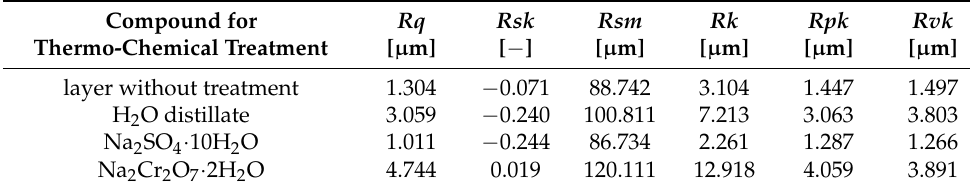
Table 6. Roughness parameters of studied layers. Compound for Thermo-Chemical